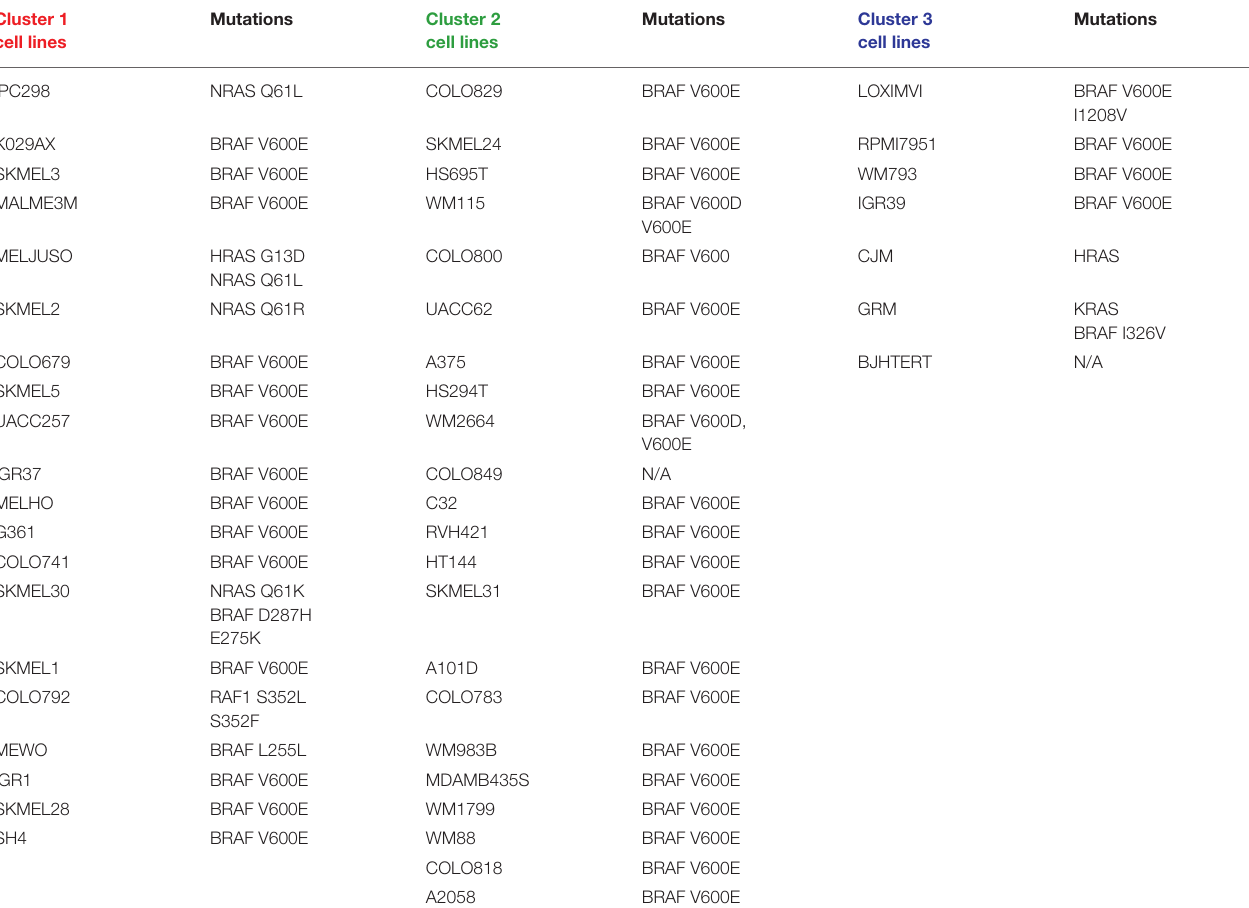
TABLE 2 | Cluster membership and genomic characterization of cell lines. Cluster 1 cell